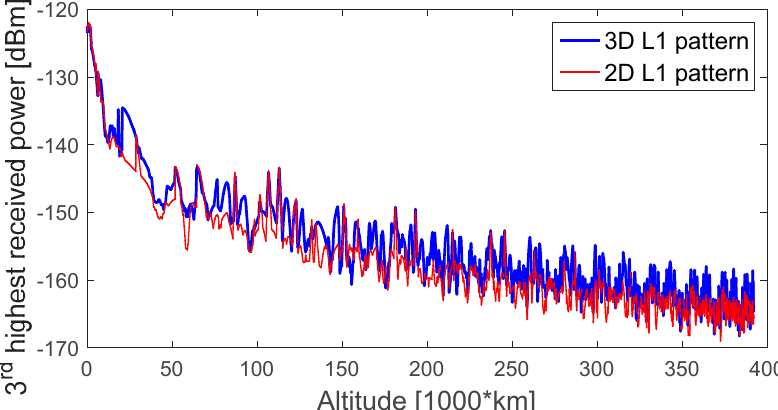
Figure 8. Third-highest received power level of GPS L1 signals, during the considered MTO, for a 0 dBi receiver gain pattern.